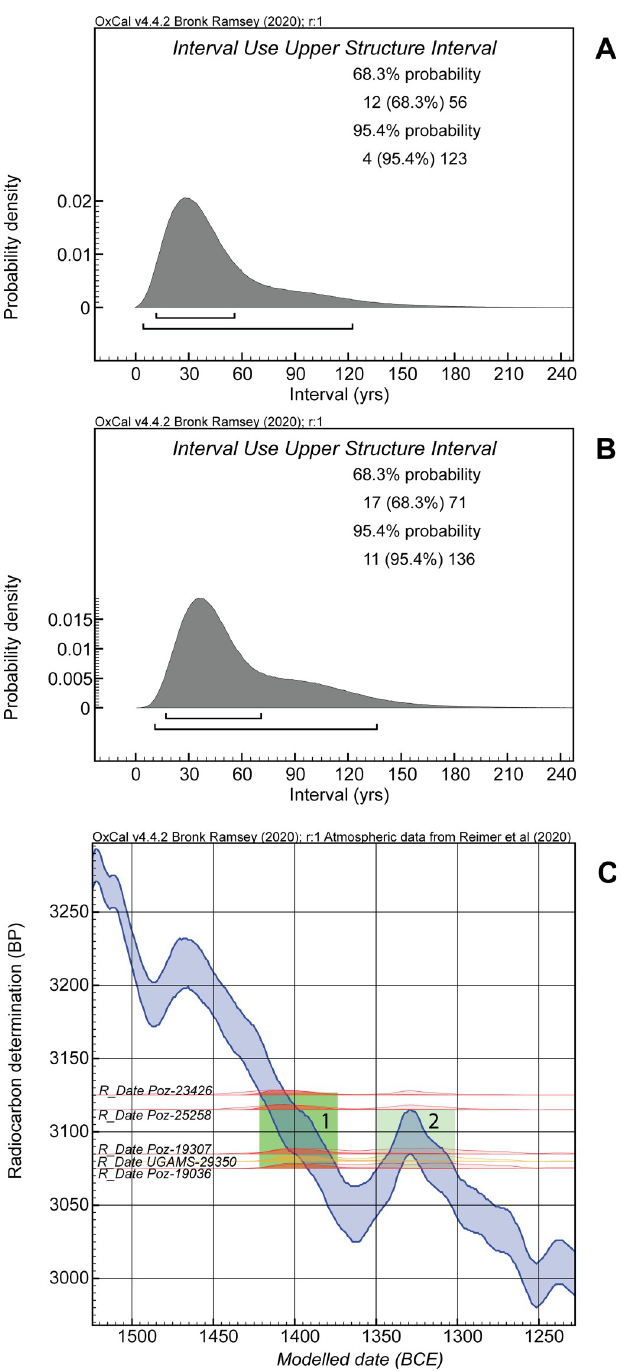
Fig 18. The results of an OxCal Interval query applied to the Noceto upper tank use phases in Fig 17A and 17B to estimate the period of time after construction through end of use of the upper tank and placement of the upper tank use period versus the 14 C calibration curve. A. The use period from the Fig 17A model with all data. B. The use period from the Fig 17B model with UGAMS-29350 re-assigned. C. The five 14 C dates from the upper tank use period (Fig 17B model) shown as placed against the calibration curve. The hollow distributions indicate the unmodelled calibrated calendar age probabilities; the solid distributions indicate the modelled calendar age probabilities. The area labelled as 1 indicates the most likely range for these data and a shorter period of use for the upper tank; the area labelled as 2 is the alternative placement due the wiggle in the calibration curve.